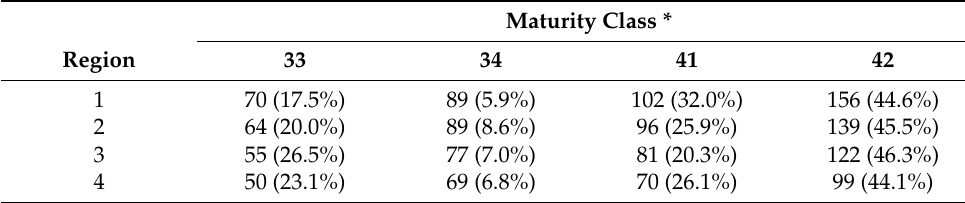
Table 1. Stand age (basal area weighted average, year) and fraction (%) of total number of sample plots in the different stand maturity classes (according to the Swedish National Forest Inventory (NFI)) included in the